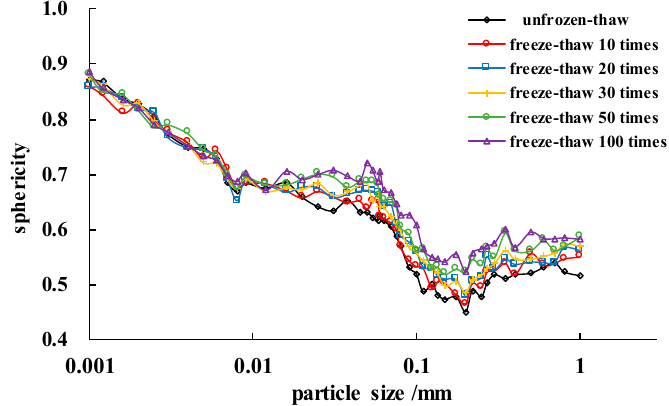
Figure 11. The sphericity curves of silt.